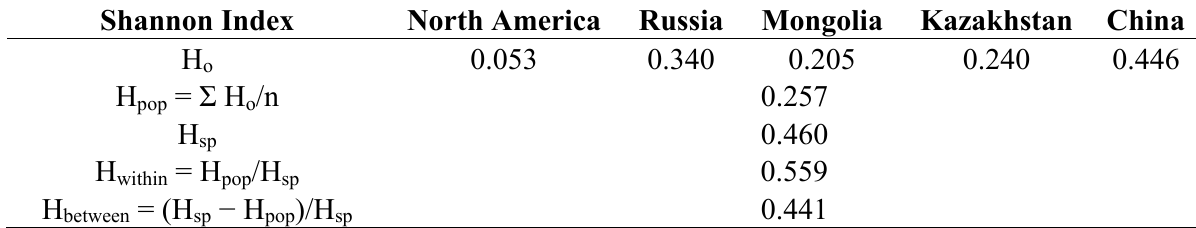
Table 3. Shannon diversity indices for five geographic groups.